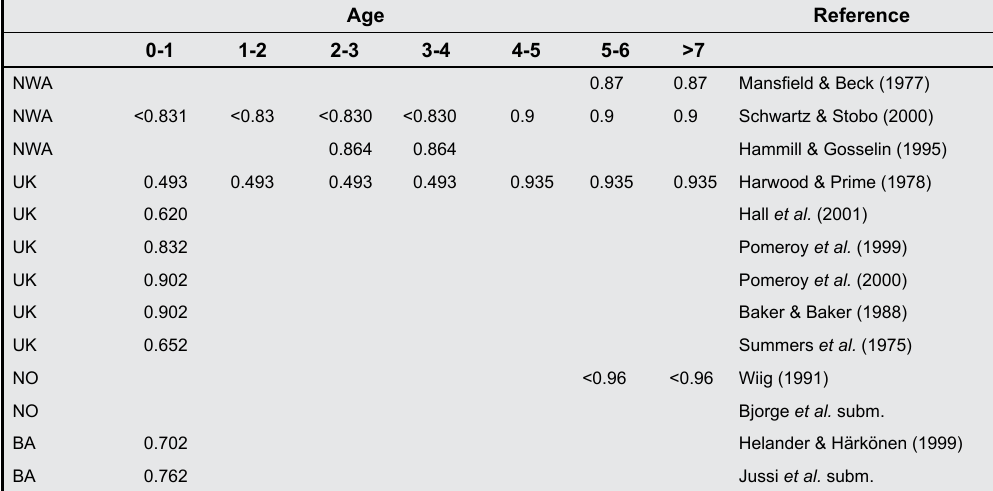
Table 5. Age specific survival rates for female grey seals in northwest Atlantic (NWA), British (UK), Norwegian (NO), and Baltic (BA) grey